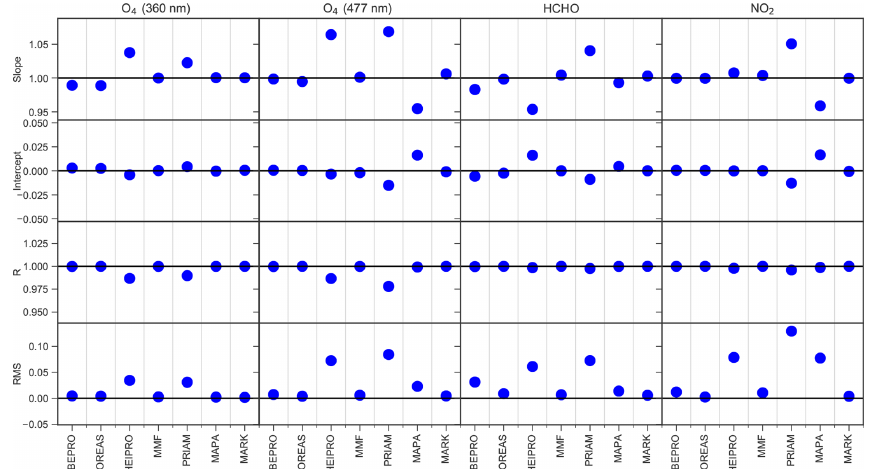
Figure 4. Slope, intercept, regression coefficient, and root-mean-square difference (RMS) of the correlation between the SCDs from the individual forward models and the median SCDs from all models. RMS and intercept values are in units of 10 43 molec 2 cm − 5 for O 4 and 10 17 moleccm − 2 for HCHO and NO 2 .